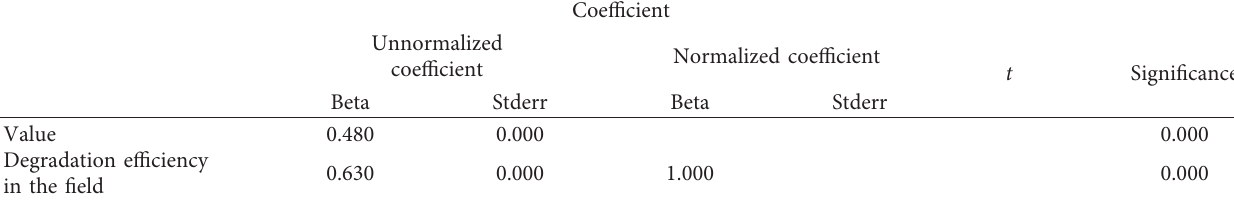
Table 5: Correlation coefficient of linear regression equation.